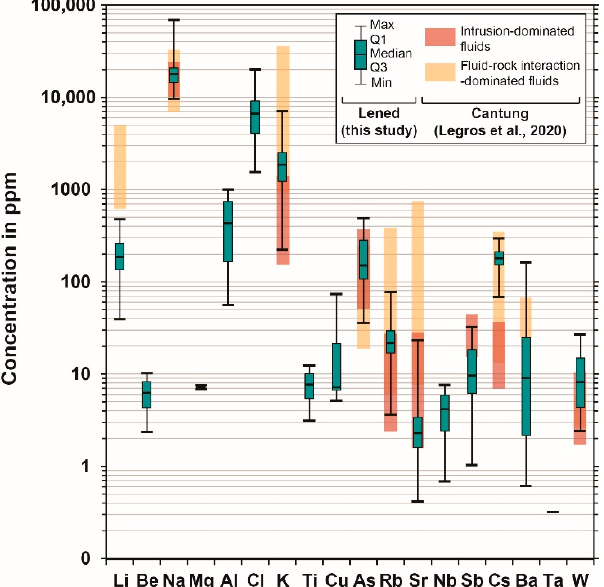
Figure 5. Trace element results for fluid inclusions (N = 25) of the Lened deposit (quartz host). All data are displayed as box and whisker plots showing the distribution of concentrations for each element, as minimum value (Min), first quartile (Q1), median, third quartile (Q3) and maximum value (Max). Individual analyses are not reported on the diagram, since all measurements are interpreted to belong to a single population. See detailed LA-ICPMS results within Tablel S3. The Lened data are compared to the Cantung W skarn deposit (located ca. 60 km SE of Lened, in the NWT, Canada; Figure 1A). The red boxes represent trace element data in fluid inclusions from intrusion-related fluids, and the yellow boxes represent trace element content of a more evolved fluid that interacted with the surrounding rocks [24] (both boxes represent minimum to maximum val- ues).